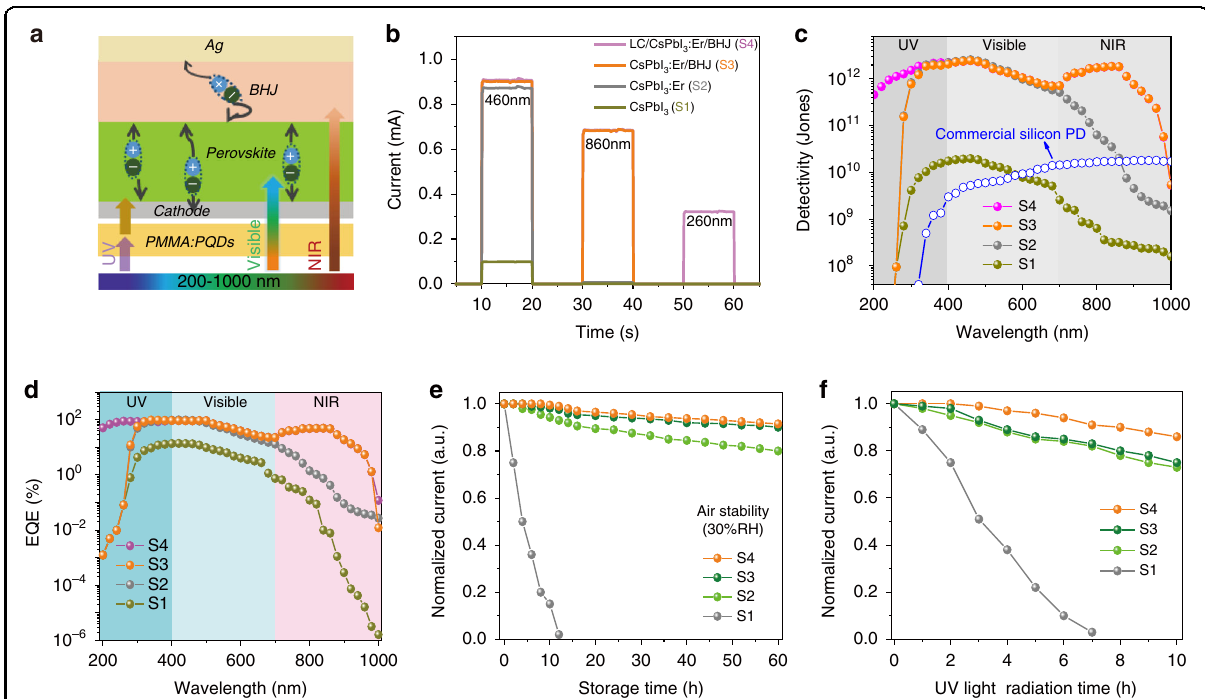
Fig. 5 Performance of broadband PDs. a Charge generation and transport mechanism of a broadband PD. b Photocurrents of the ITO/ETL/CsPbI 3 / Ag (S1), ITO/ETL/CsPbI 3 :Er 3 + (7.7%) PQDs/Ag (S2), ITO/ETL/CsPbI 3 :Er 3 + (7.7%) PQDs/BHJ/Ag (S3) and Cr/Ce/Mn-LC/ITO/ETL/CsPbI 3 :Er 3 + (7.7%) PQDs/ BHJ/Ag (S4) devices under the 260 nm, 460 nm, and 860 nm, respectively. c D* of the S1 – S4 devices and commercial Silicon PD. d EQE of the S1 –